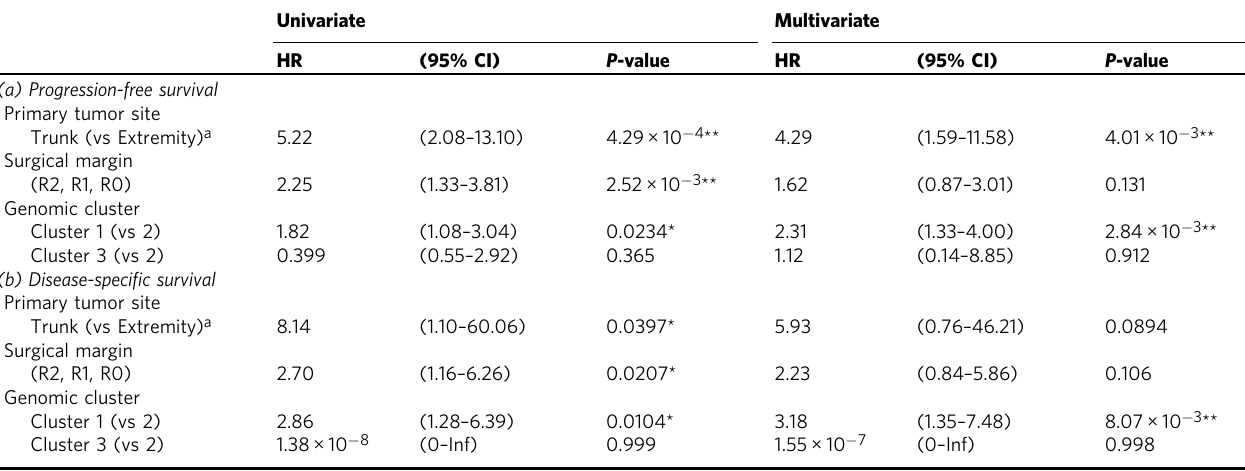
Table 2 Cox-regression analysis of progression-free (a) and disease-speci fi c (b) survival with genomic clustering. Univariate